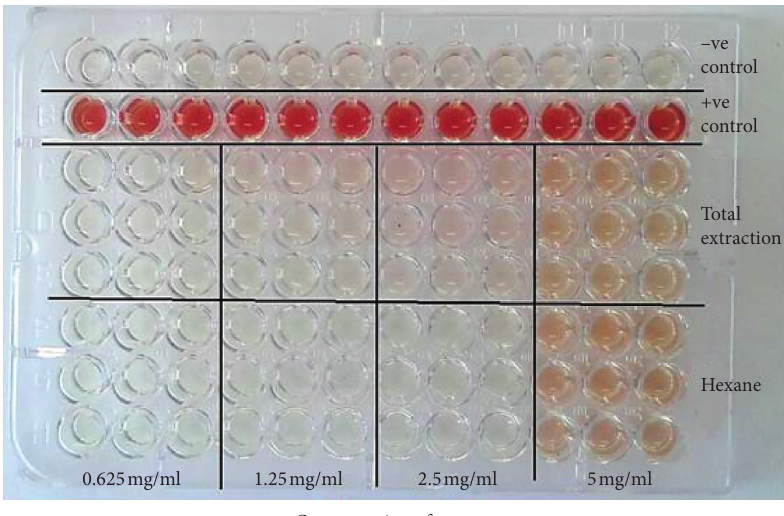
Figure 2: A 96-well plate for haemolysis of sheep erythrocytes exposed to P. curatellifolia crude (total) and hexane extract. The negative control ( − ve control) was a measure of spontaneous haemolysis and contained centrifuged erythrocyte suspension in PBS from which an aliquot of the supernatant was withdrawn and mixed with Drabkin’s reagent. The positive control (+ve control) contained uncentrifuged erythrocytes in PBS from which an aliquot was withdrawn and mixed with Drabkin’s reagent to give 100%